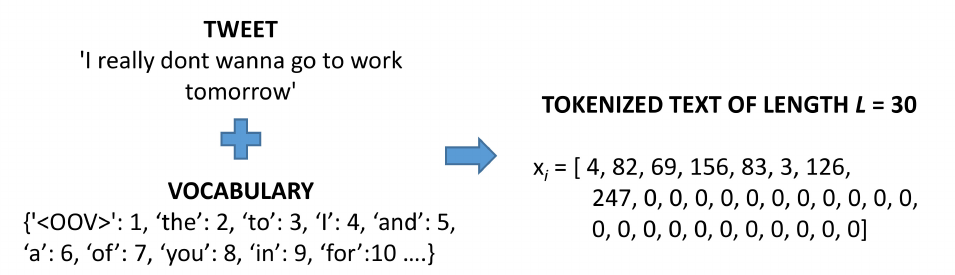
Figure 7. The tokenization process of the tweets. OOV refers to ‘out of vocabulary’. As the reader can see from this figure a tweet may not always be